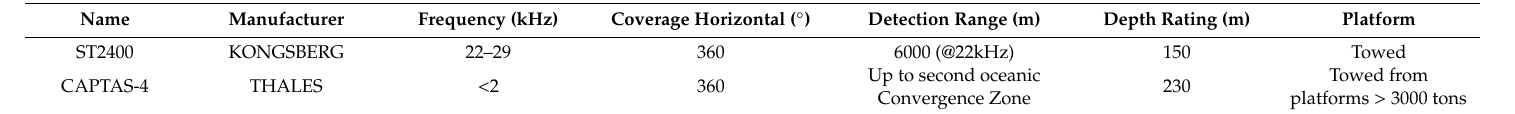
Table 12. Acoustic sensor: variable depth sonar